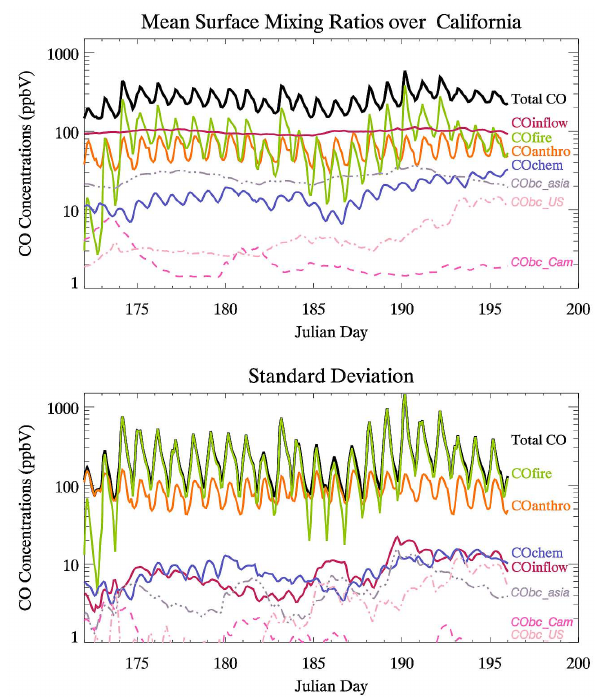
Fig. 6. Time series of simulated average total CO and CO tracer surface mixing ratios over CA. Shown are the mean and standard deviation over the time period 20 June–15 July. Note the logarith- mic